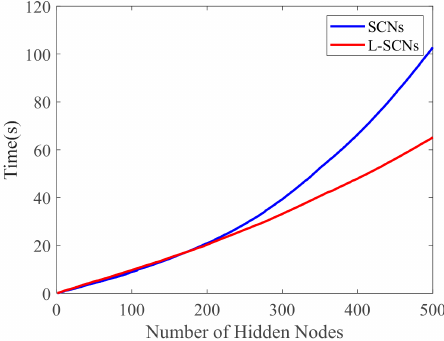
Figure 3. Modeling time of SCNs and L-SCNs.